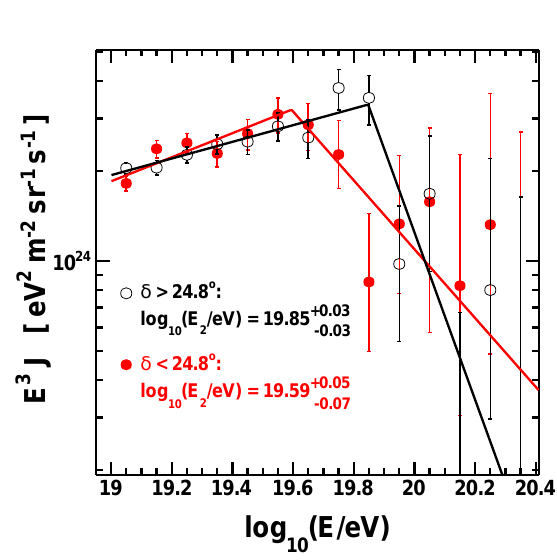
Figure 2. The TA SD energy spectrum in the two declination bands [13]. Filled red circles correspond to the spectrum in the lower declination band, − 15 . 7 ◦ < δ < 24 . 8 ◦ , and open black circles represent the spectrum in the higher declination band, 24 . 8 ◦ < δ < 90 ◦ . Solid lines show the broken power law fits that correspond to each declination band. The cuto ff energies (log ( E 2 / eV)) are 19 . 59 + 0 . 05 for the lower and 19 . 85 + 0 . 03 for the 10 − 0 . 07 − 0 . 03 higher declination bands. The cuto ff energies in the two declina- tion bands are 4 σ di ff